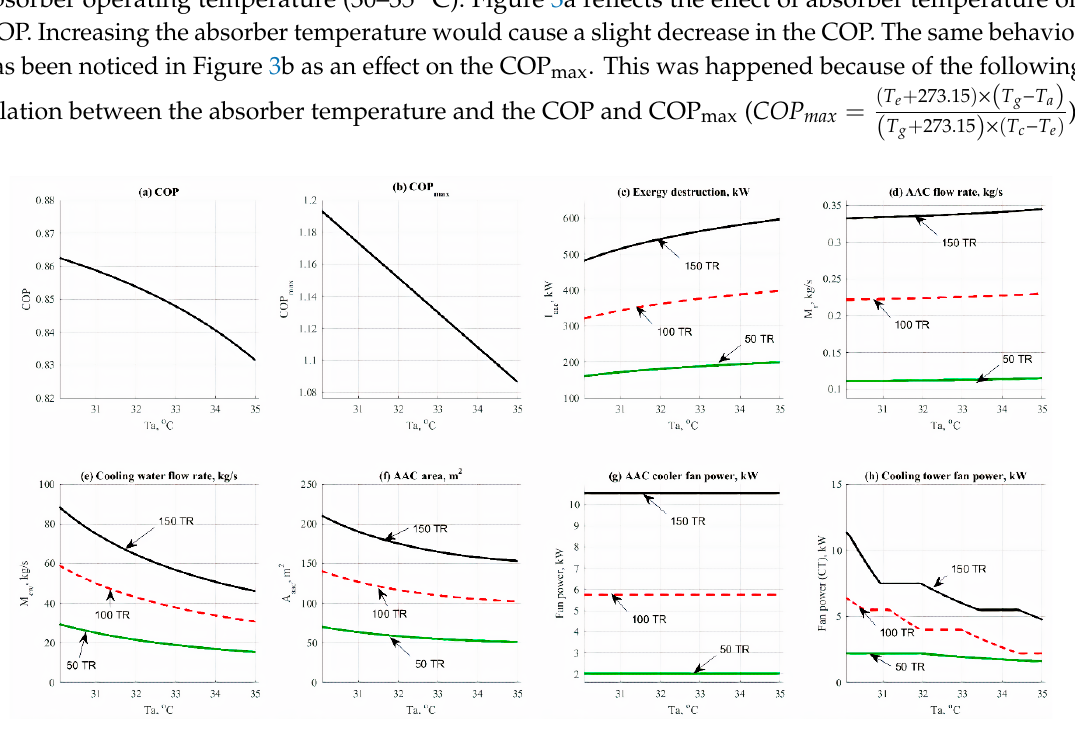
Figure 3. Data results based on the effect of the absorber temperature parameter.